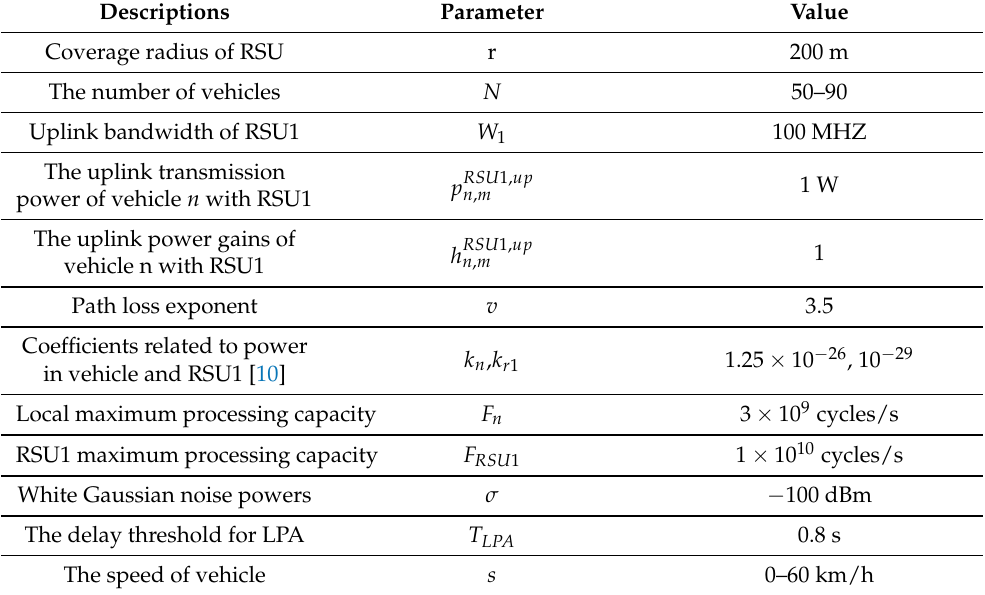
Table 1. Simulation